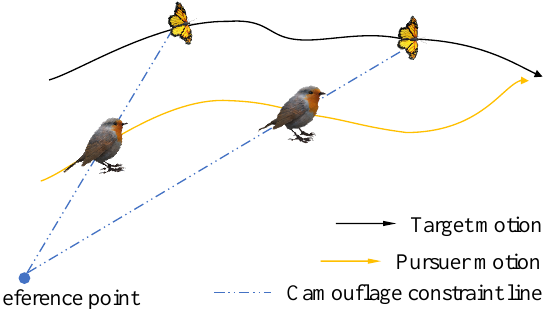
Figure 7. Illustration of motion camouflage: a pursuer flies towards a moving target, camouflaging its motion by staying on the continually changing camouflage constraint